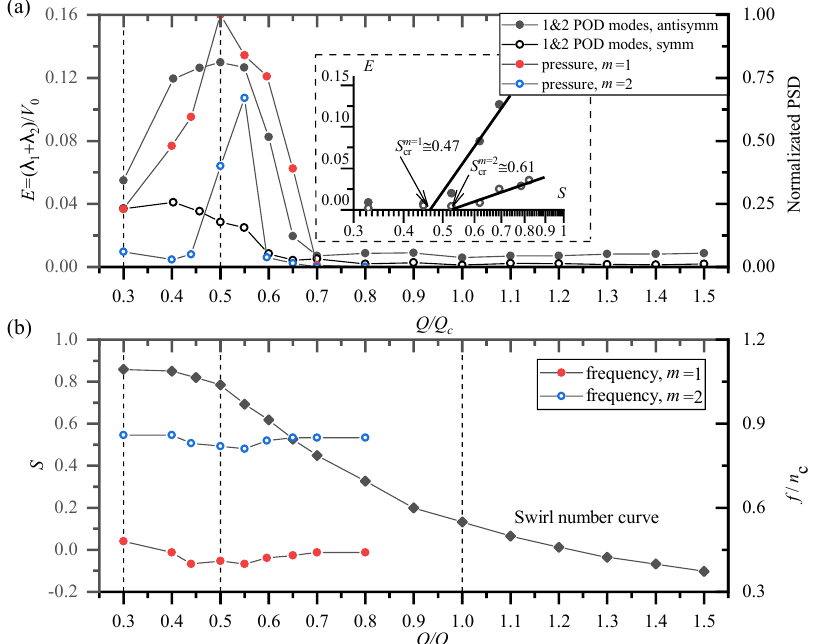
Figure 7. ( a ) Kinetic energy E and the wall pressure amplitudes of the m = 1 and m = 2 modes as a function of flow rate. The inset shows the linear fit to determine the bifurcation point of both modes. ( b ) Swirl number and mode frequencies as a function of flow